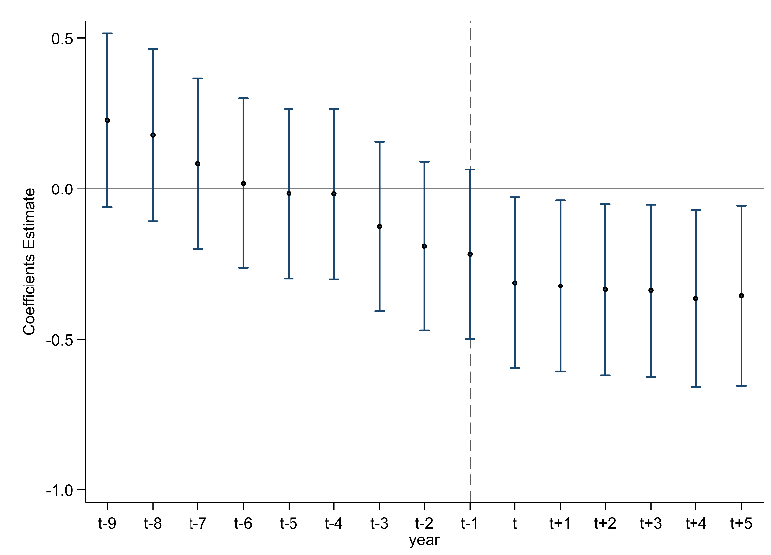
Table 2. Parallel trend test.